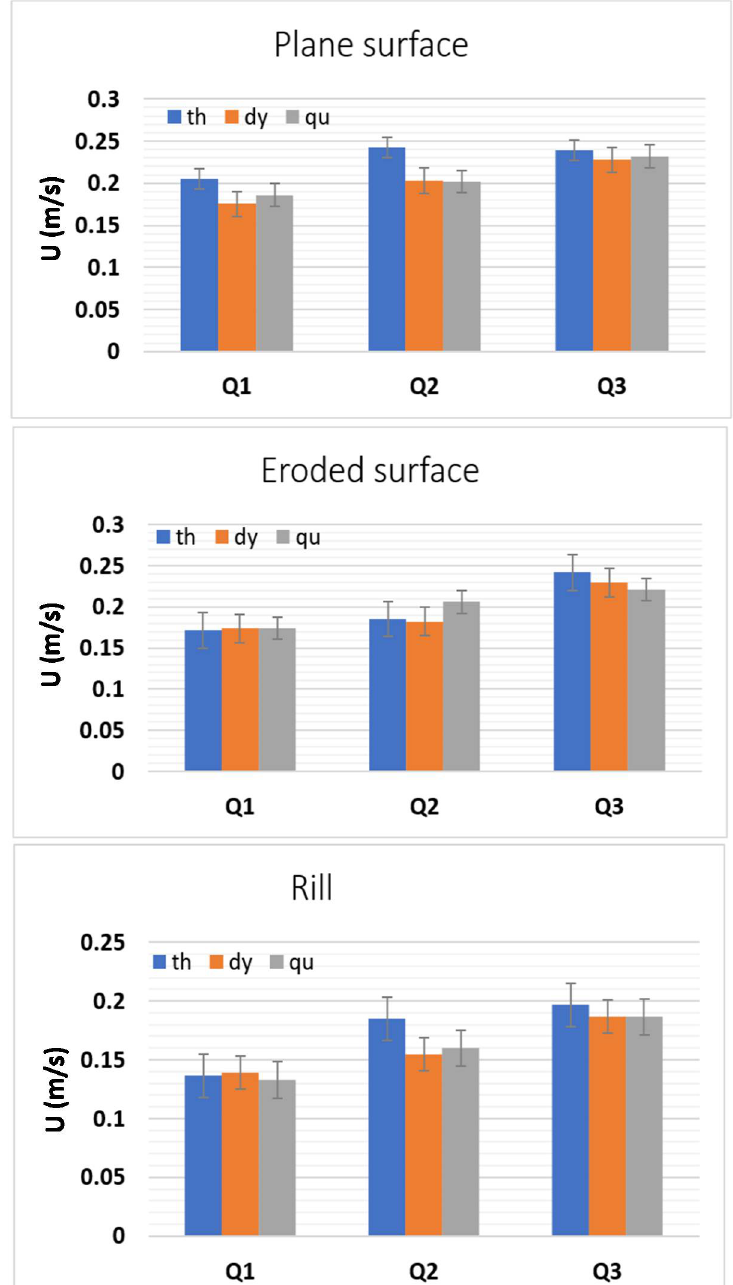
Figure 6. Comparison of injected tracer leading-edge velocities U measured for the three tracers (total of 81 tests for each tracer), for the plane surface, eroded surface and rill flows. Mean and standard deviation are presented for each flow discharge Q (detailed data in Tables 1– 3).